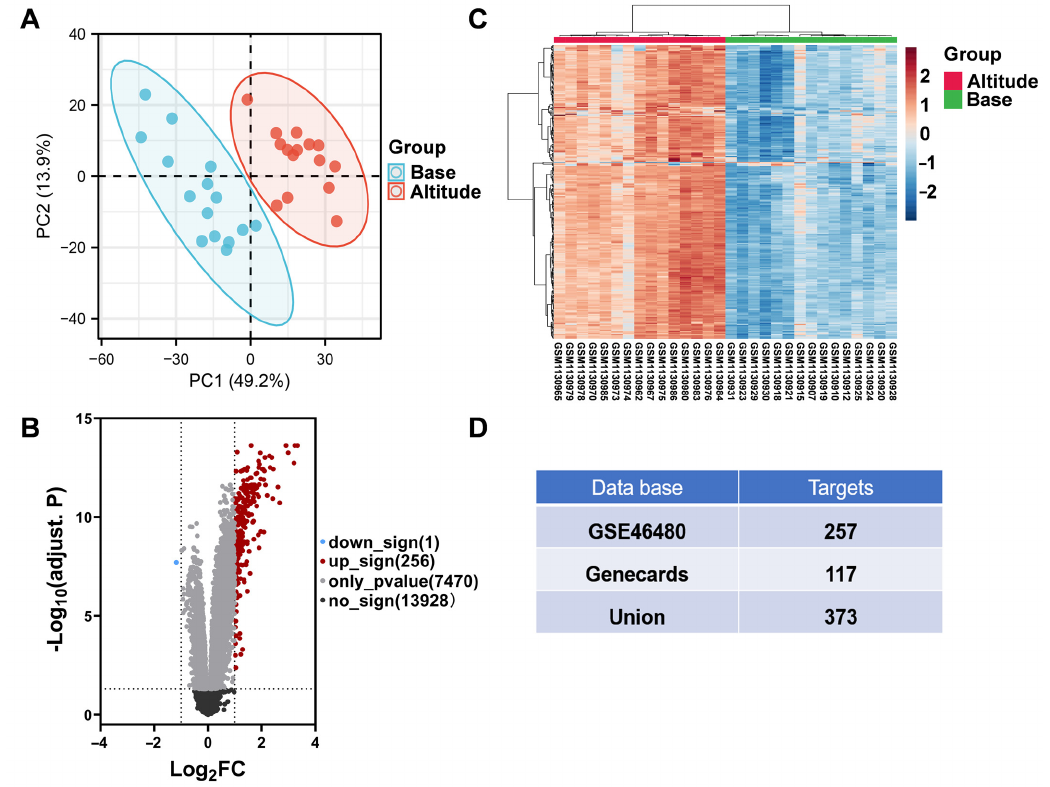
Figure 3. Screening for HAPC-related targets. ( A ) PCA analysis of gene expression in volunteers from the GSE46480 dataset. ( B – C ) Volcano plot ( B ) and clustered heat map of DEGs ( C ) from volunteers in the plateau environment compared to baseline. ( D ) The union of HAPC targets from different databases.